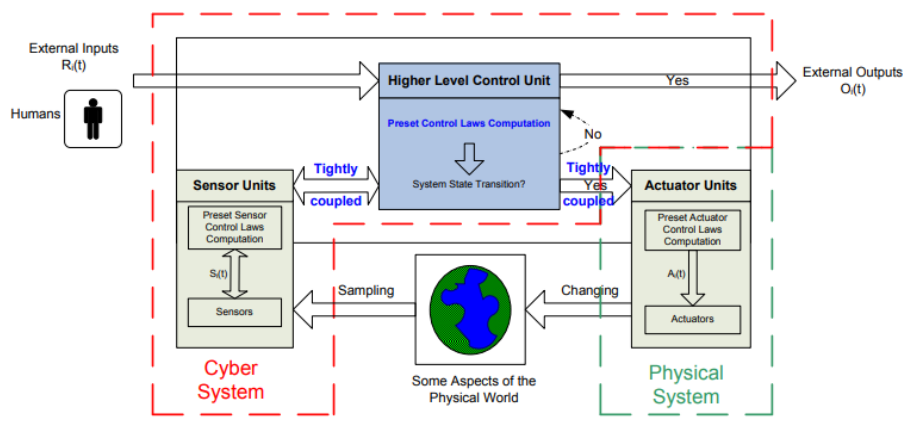
Figure 12. Typical architecture of an embedded system